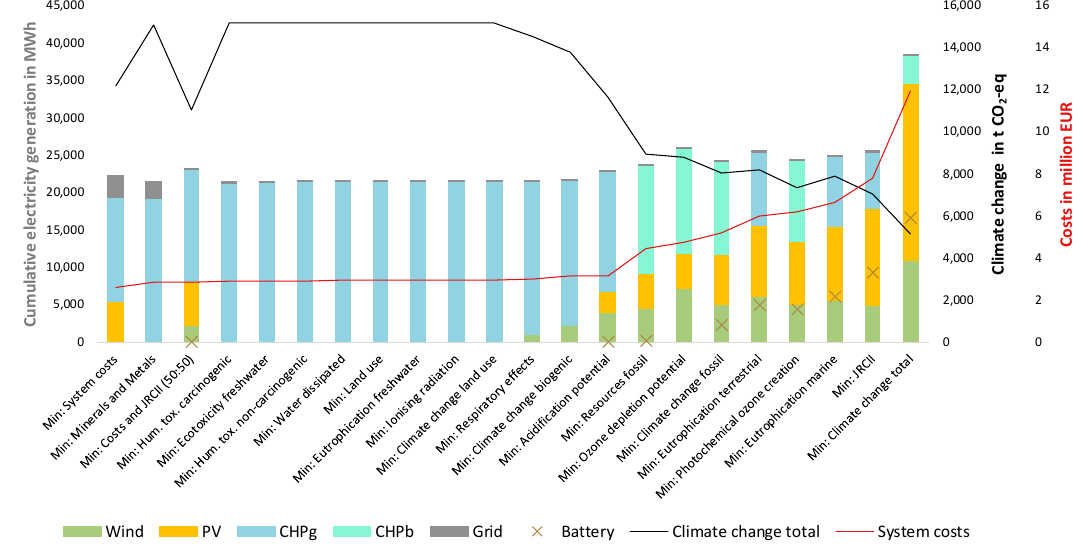
Figure 3. Optimum energy mix 2050 (bars), system costs (red line) and climate change (black line) for di ff erent optimisation goals.